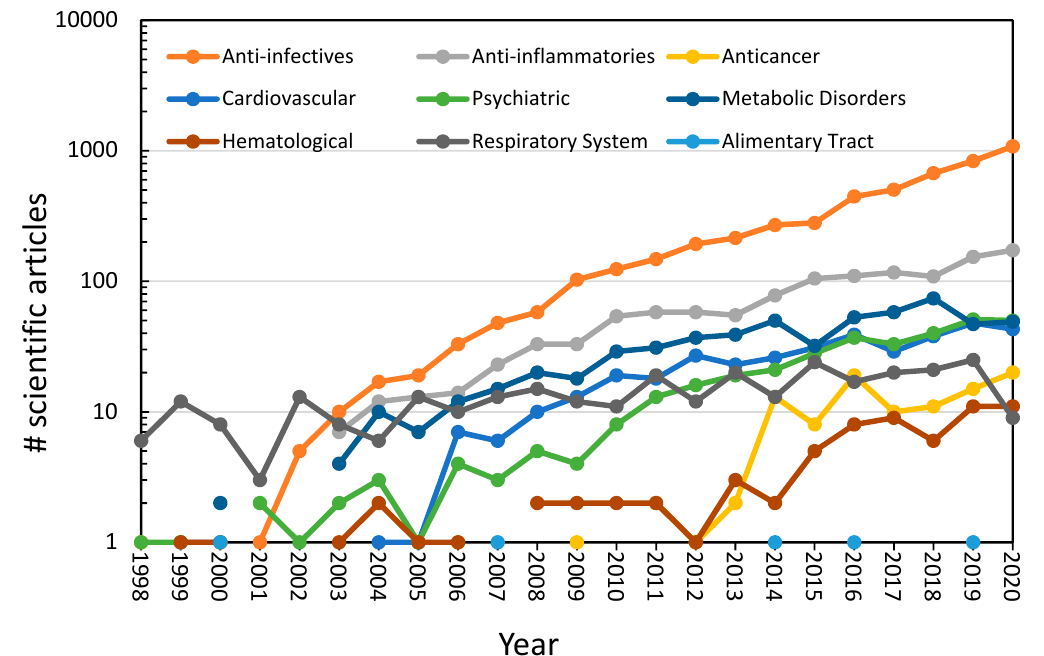
Figure 22. Research trends of pharmaceuticals in water and wastewater worldwide in the last 22 years. Data obtained from different research chains in Scopus as Table 1 describes.